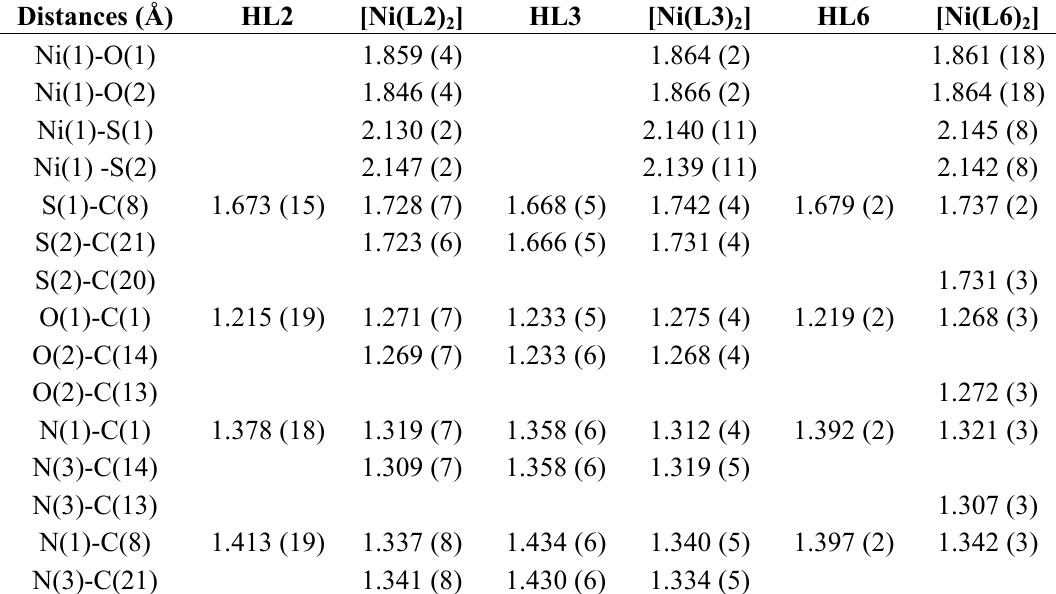
Table 2. Some structure parameters of the determined